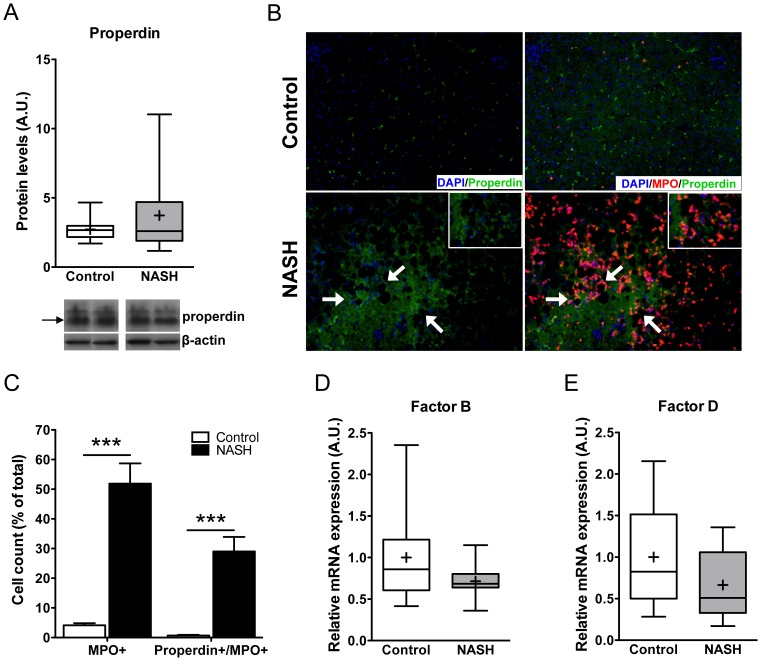
Alternative pathway related factors in NASH.A) Hepatic properdin protein levels were not significantly different between subjects with a healthy liver and subjects with NASH (p = 0.92). B) Representative images of immunofluorescent stainings for properdin (green) and myeloperoxidase (MPO, red), showing pronounced extracellular accumulation of properdin in areas where neutrophils surround steatotic hepatocytes in subjects with NASH (100× magnification), whereas control subjects with healthy livers display no or little properdin accumulation and neutrophil infiltration (100× magnification). C) Quantitative analysis of immunofluorescent staining for MPO+ cells (***p<0.001) and properdin+/MPO+ cells (***p<0.001) in healthy livers and livers from subjects with NASH. D) Hepatic factor B mRNA expression was comparable in subjects with healthy livers and subjects with NASH (p = 0.26). E) Similar mRNA expression of factor D in the study groups (p = 0.29).